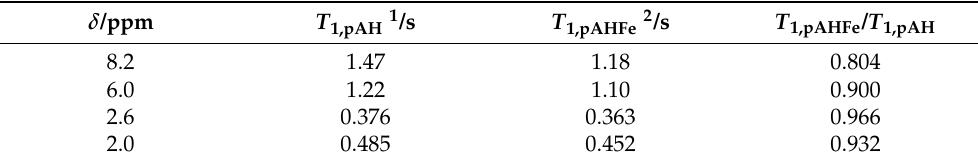
Figure 6. 1 H NMR spectrum for poly(AH)Na in the absence ( a ) and presence of 0.1 ( b ), 3.1 ( c ), and 9.1 mM of Fe(NO 3 ) 3 (D 2 O) ( d ). Assignments are indicated as a, b, c, and d. Asterisks denote the signals due to the residual protons in solvents.